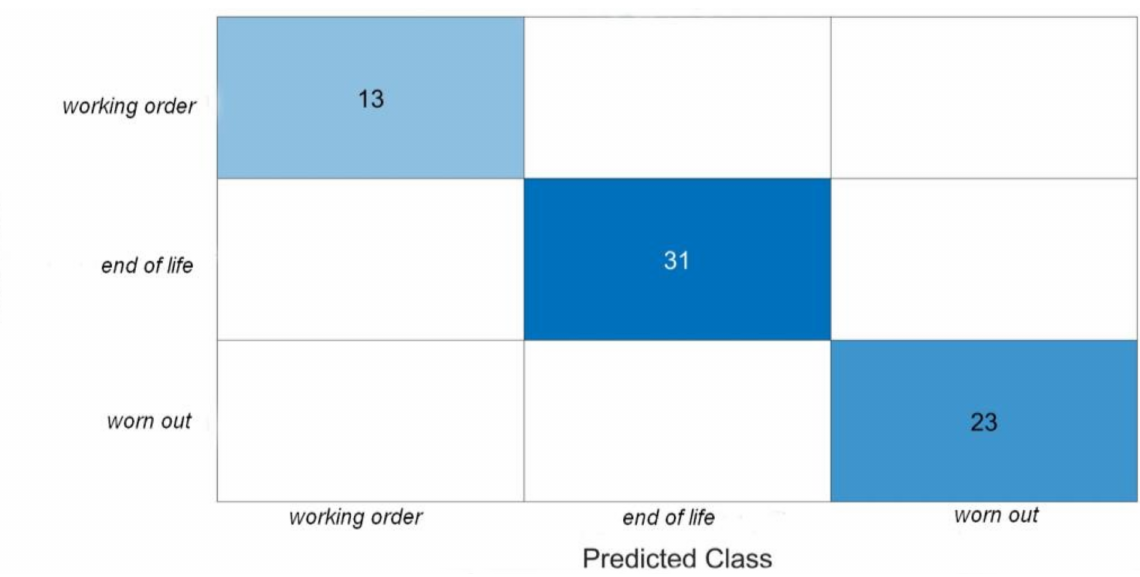
Figure 11. Matrix for classifying the wear state of the pump based on features obtained from pressure